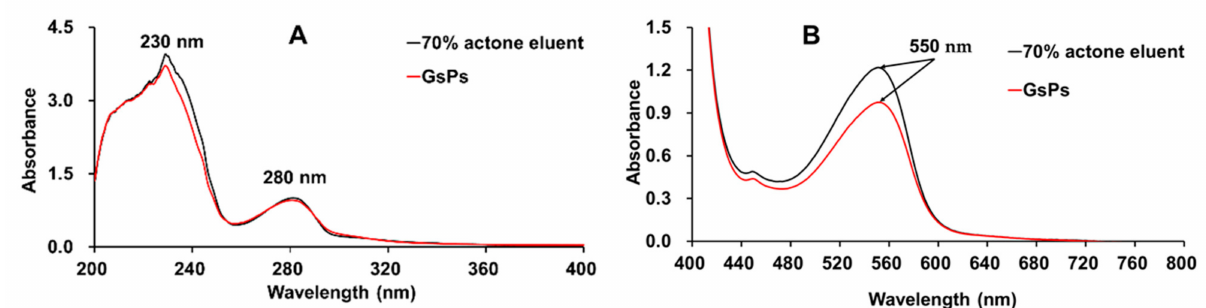
Figure 1. ( A ) The ultraviolet spectrum of the 70% acetone eluent of the rhizome of F. dibotrys and GsPs in methanol solution, ( B ) the visible spectrum of the 70% acetone eluent of the rhizome of F. dibotrys and GsPs after color development by n-butanol-hydrochloric acid colorimetric method.